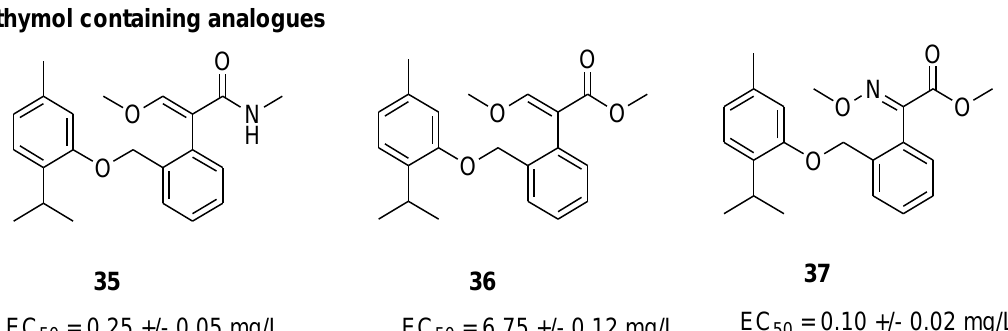
Figure 9. Structure of representative compounds and EC 50 values against Sclerotinia sclerotiourum (azoxystrobin EC 50 = 18.75 ± 1.10 mg/L) [EC 50 values from Reference 31].